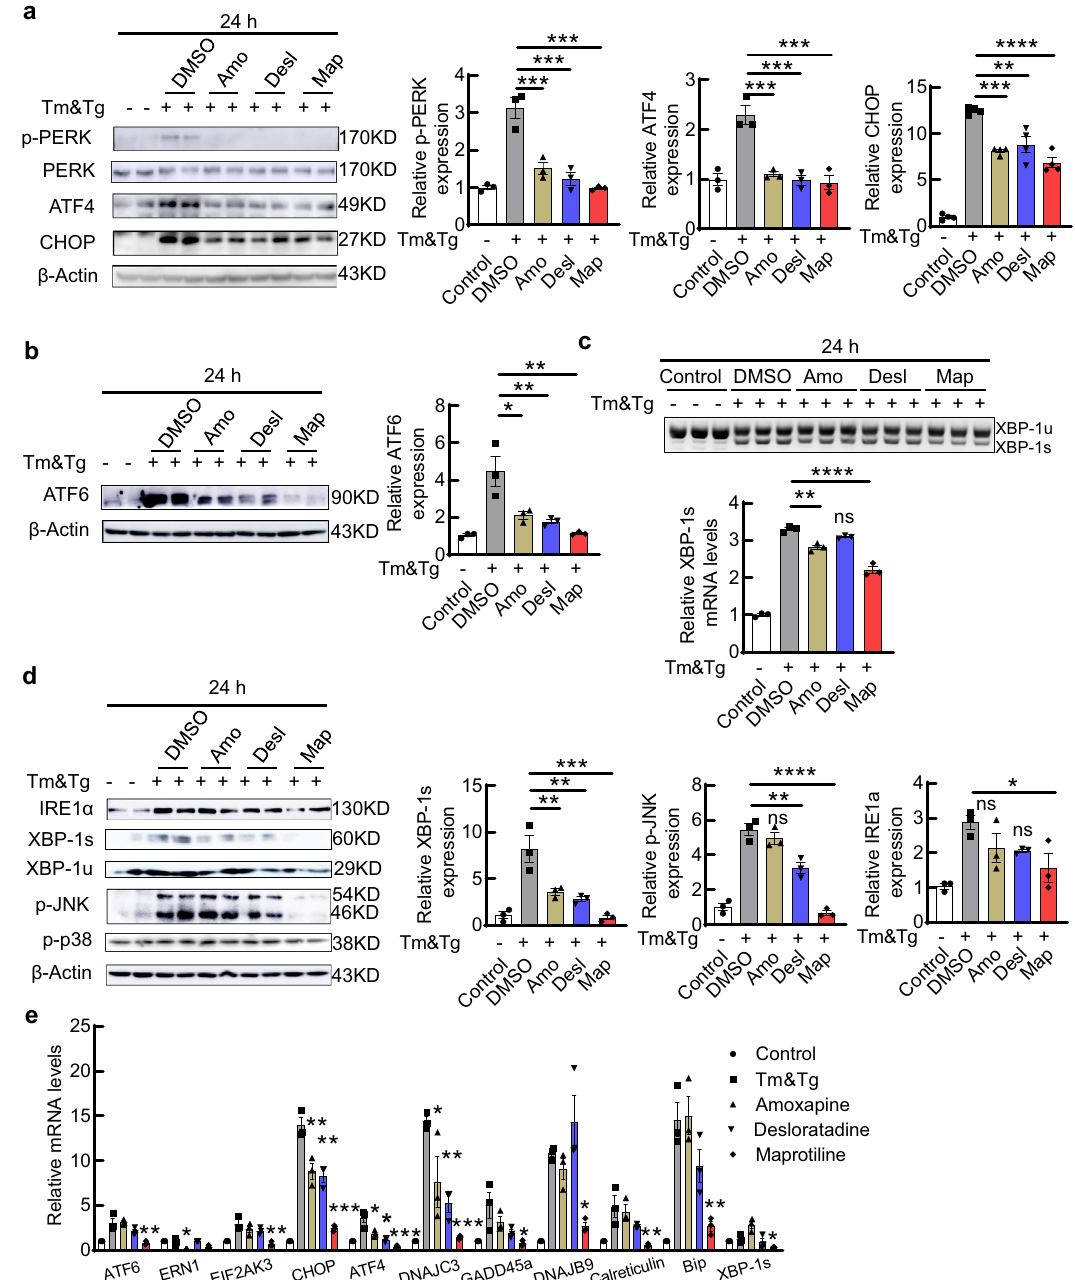
Fig. 2 | Amo, Desl and Map inhibit the signaling cascades downstream of the three UPR pathways. a Immunoblot of HEK293T cells showing the effects of the three compounds on the PERK-CHOP pathway. Quanti fi cation of phosphorylated PERK (p-PERK), ATF4 and CHOP 24h after DMSO, Amo, Desl, or Map (10 µ M) treatment in the presence of Tm/Tg (1 µ M), relative to control (without Tm/Tg). b Immunoblot showing the effects of the three compounds on the ATF6 pathway. Quanti fi cation of total ATF6 protein level 24h after DMSO, Amo, Desl or Map treatment in the presenceof Tm/Tg, relative to control(without Tm/Tg). c RT-PCR showingthemRNAlevelsofun-splicedandsplicedformsofXBP-1(XBP-1uandXBP- 1s). Quanti fi cation of XBP-1s mRNA level 24h after DMSO, Amo, Desl, or Map